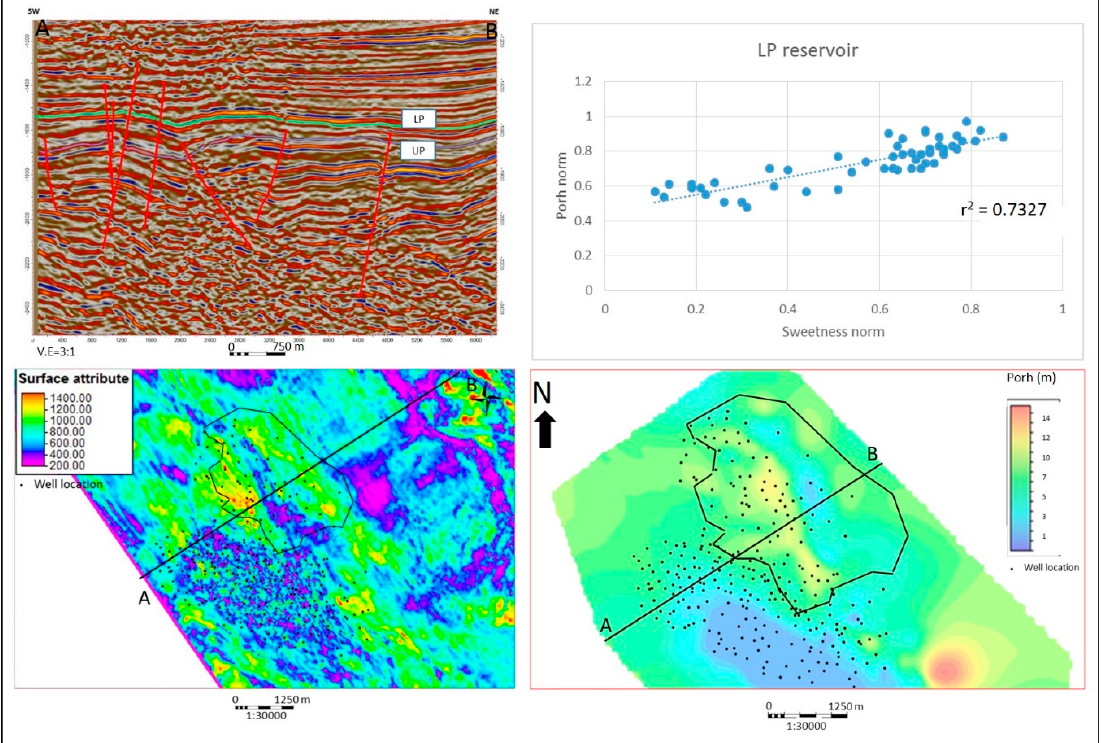
Figure 15. Correlation of the sweetness attribute and porosity–thickness map of the best part of the “LP” reservoir with clear seismic survey measurements.